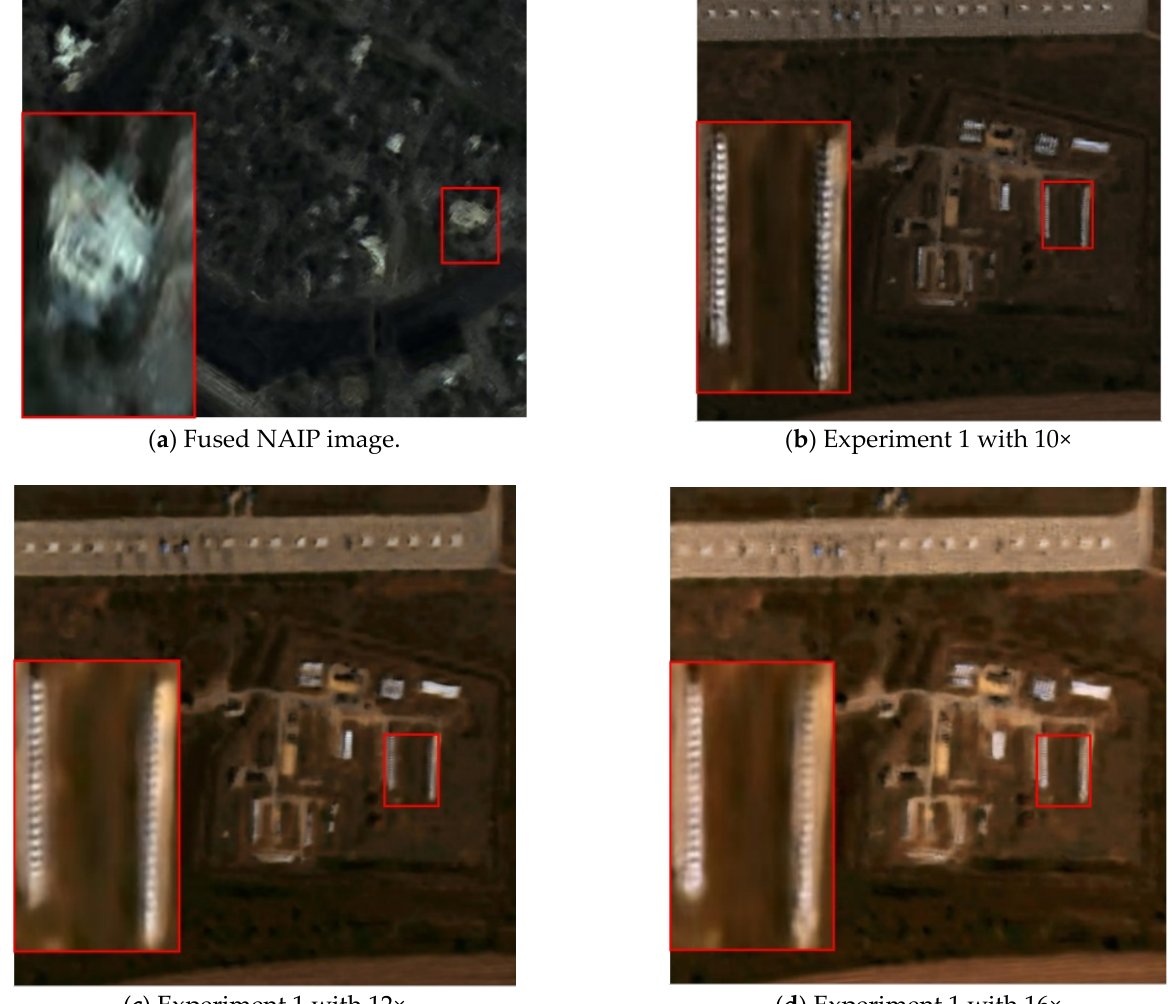
Figure 10. Image registration effect. With imperfect registration in Experiment 3, the resolution difference of 10× between Sentinel2 and NAIP images is much more difficult to bridge (image in ( a ) is blurry). With the perfect registration in Experiment 1, even larger resolution differences resulted in much sharper fused images ( b – d ).